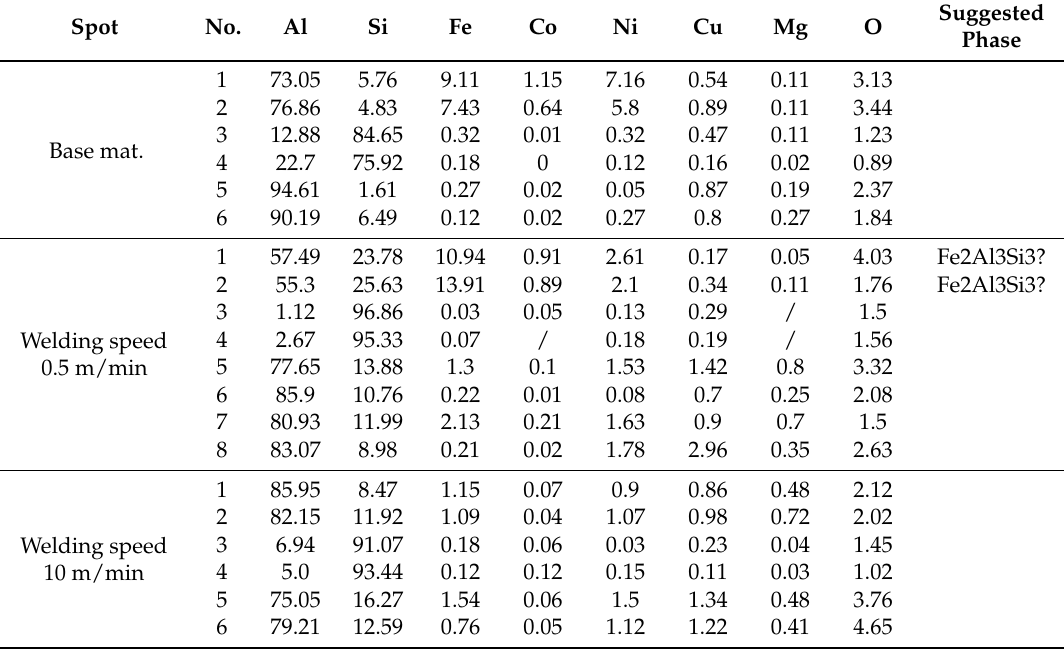
Suggested Phase